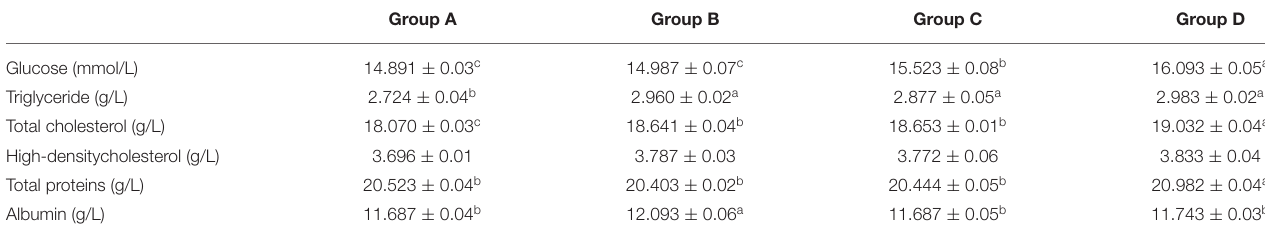
In the same row, values with different letter superscripts mean significant difference (P < 0.05), while with the same or no letter superscripts mean no significant difference (P > 0.05). Group A represents the basal diet; Group B represents basal diet supplemented with 10mg enramycin/kg; Group C represents basal diet supplemented with 100mg plectasin/kg; Group D represents basal diet supplemented with 200 mg